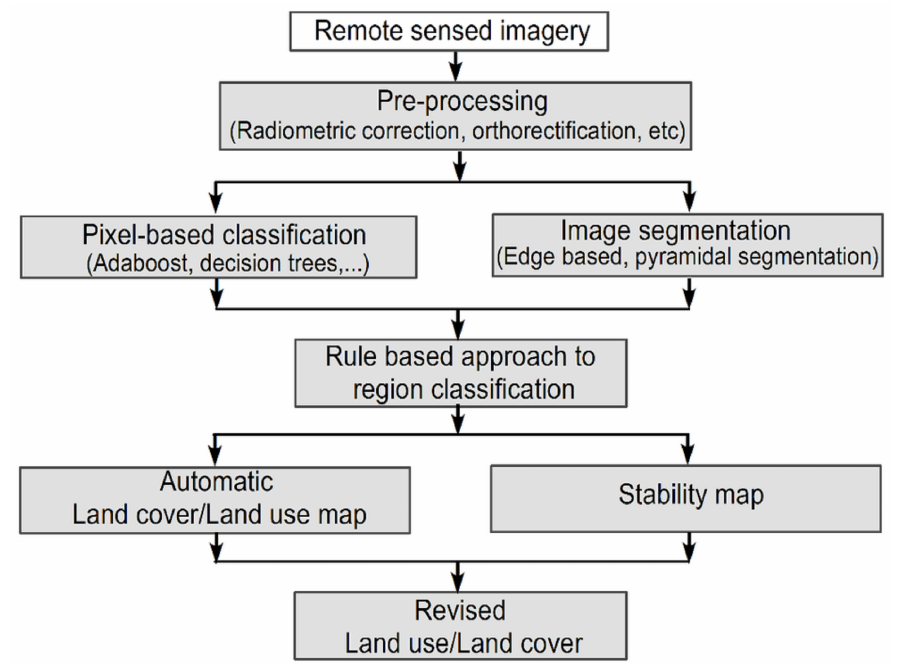
Figure 6. The hybrid approach scheme (modified from Zingaretti et al.